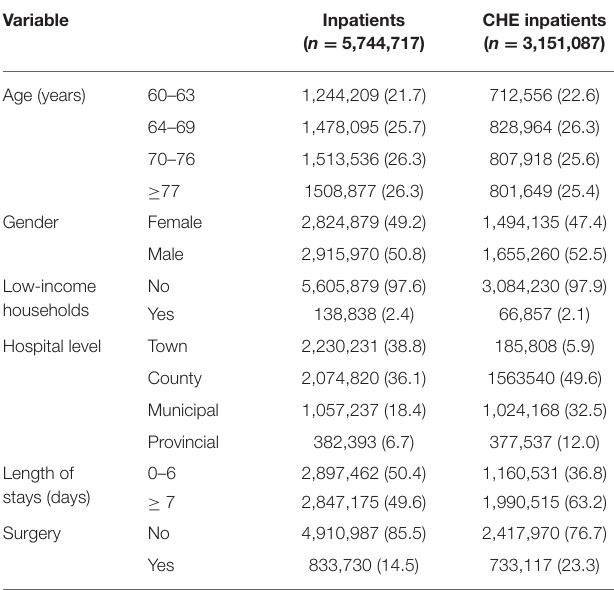
TABLE 1 | Demographic characteristics of rural elderly inpatients, from 2010 to 2016, n